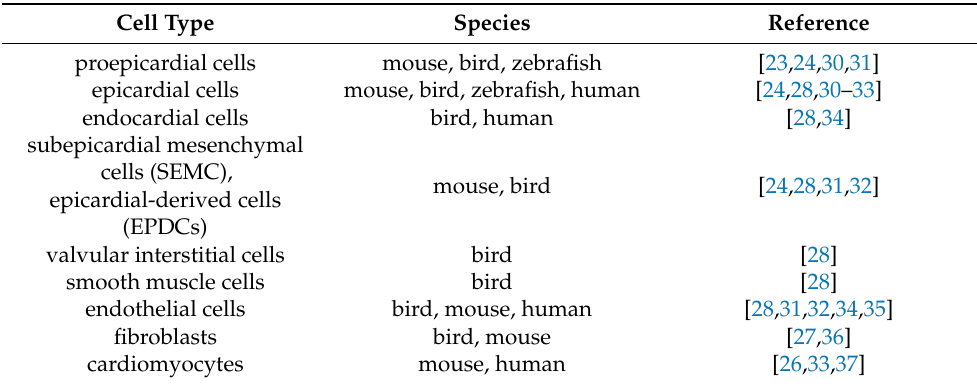
Table 1. Wt1-expressing cell types during heart